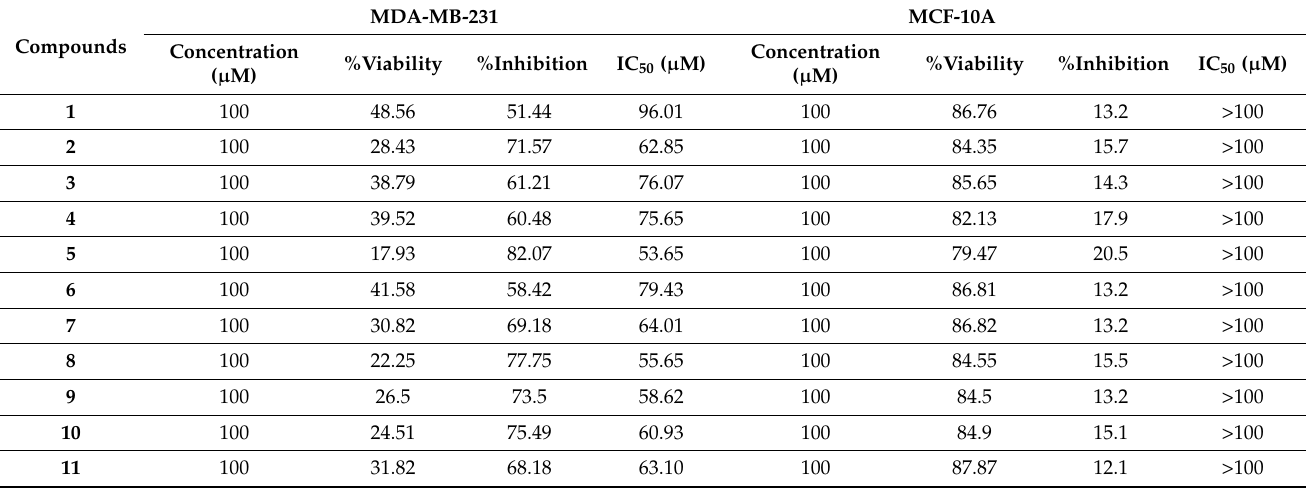
Table 3. Percentage of viability and percentage of inhibition of compounds in MDA-MB-231 and MCF-10A cell